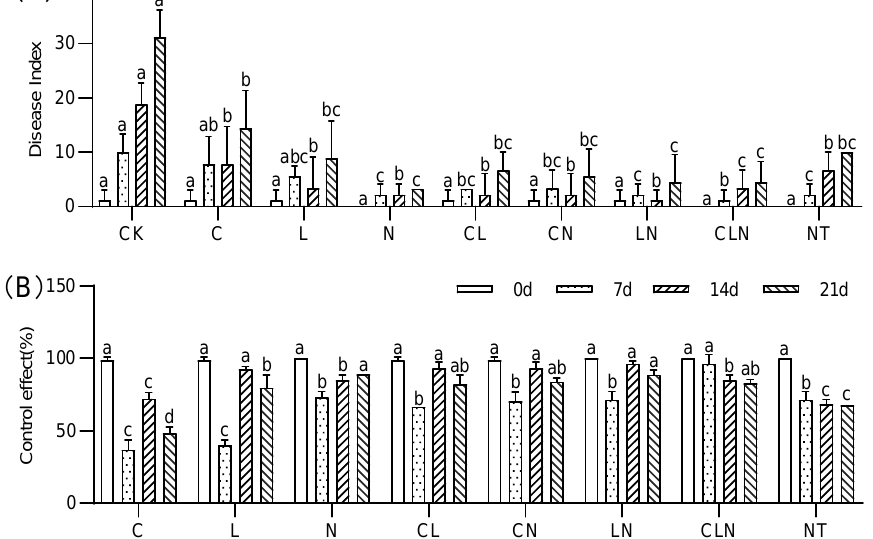
Figure 2. DI ( A ) and CE ( B ) of Chitosan, Lentinan and Ningnanmycin on PRSV in papaya in seedling stages. Whereas CK—control without the use of bio-pesticides, C—use of 0.50 g L − 1 Chitosan, L—use of 10.00 g L −1 Lentinan, N—use of 0.05 g L −1 Ningnanmycin, CL—Chitosan plus Lentinan, CN—Chitosan plus Ningnanmycin, LN—Lentinan plus Ningnanmycin, CLN—Chitosan plus Lentinan plus Ningnanmycin. All the above treatments were applied by means of root irrigation with 200 mL, foliar spraying with 200 mL, and then inoculated with PRSV virus. NT—negative control with- out PRSV inoculation. Different lowercase letters indicate significant differences at the 0.05 level.